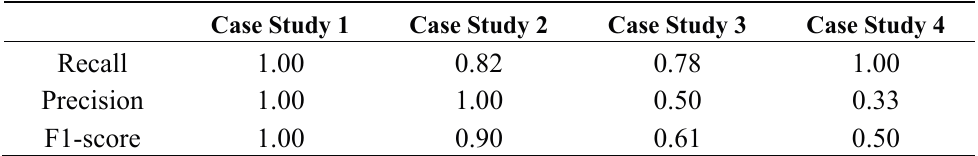
Table 7. Recall, precision and F1-Scores for the cases of study.